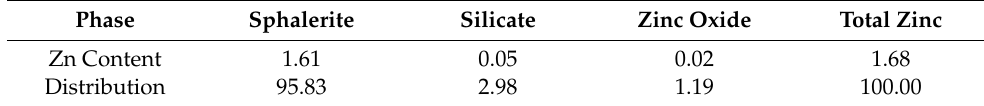
Table 5. Iron chemical phase analysis of the polymetallic ore Table 4. Zinc chemical phase analysis of the polymetallic ore (%).